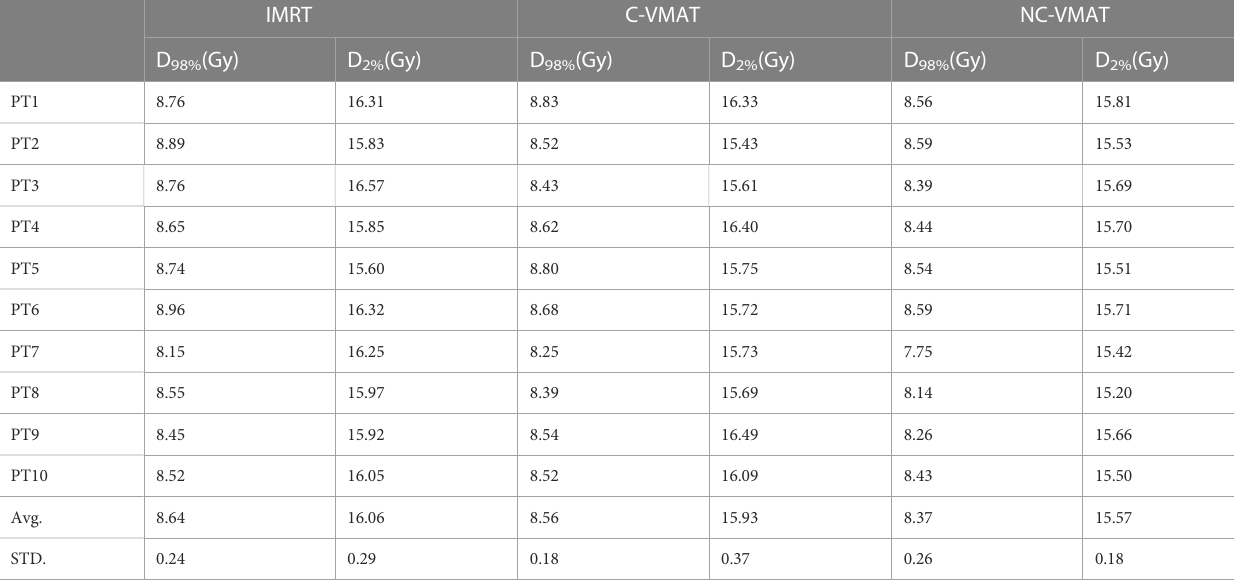
TABLE 5 The dosimetric values of hippocampus under three types of treatments for each case (IMRT, C-VMAT and NC-VMAT).